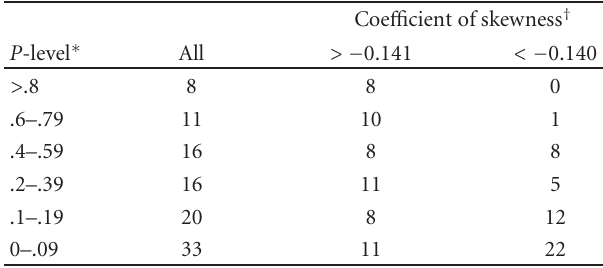
Table 1: Number of cases according to significance test for fit of LV myocyte breadths to log normal distribution by skewness of the logarithmically transformed breadths.